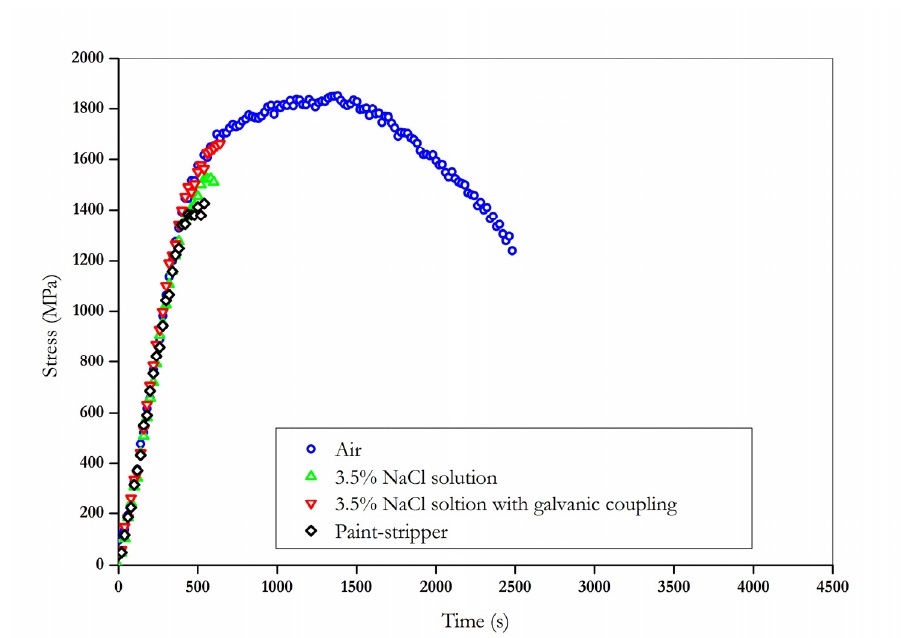
Figure 2: Stress-Time to Failure curves for AISI